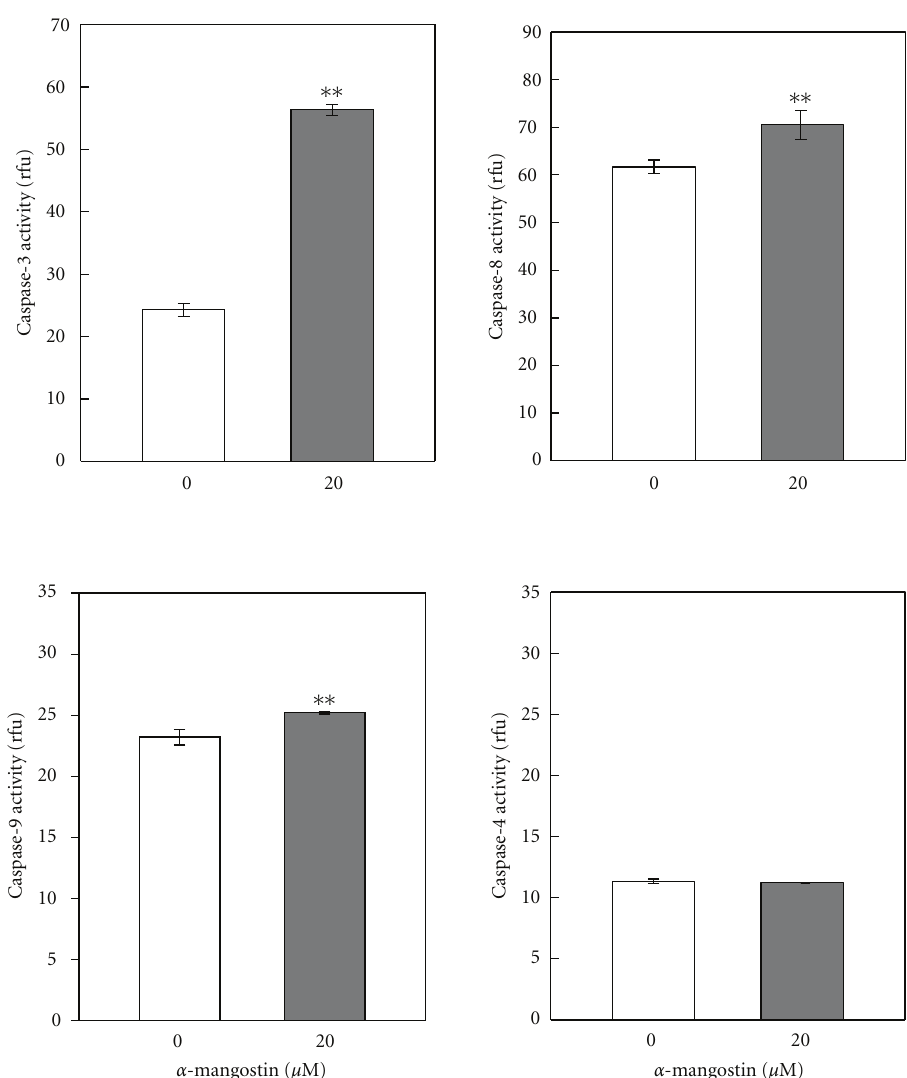
Figure 2: Caspase activity of MDA-MB231 cells after treatment with α -mangostin. Caspase activity was evaluated by luminescence assay. Activity of caspase-3, caspase-8, and caspase-9, but not caspase-4, was significantly elevated in MDA-MB231 cells treated with 20 μ M α - mangostin for 24 h ( ∗∗ P < 0 . 01). Data are presented as mean ± SD. Five samples from control and α -mangostin-treated cells were used for measurement of caspase